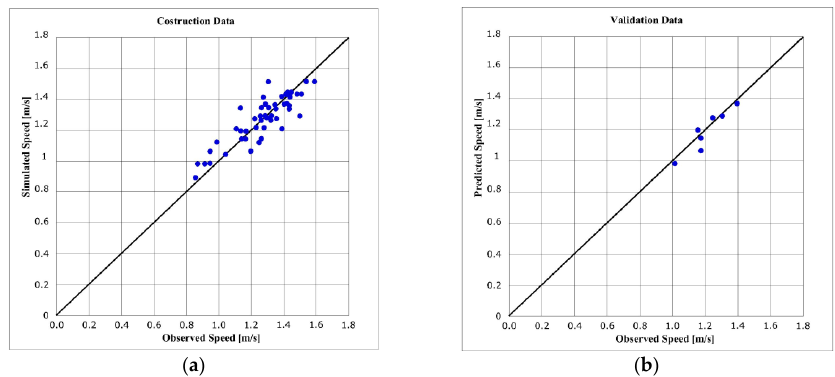
Figure 7. Comparison between observed and estimated dataset: construction phase ( a ); and validation phase ( b ).